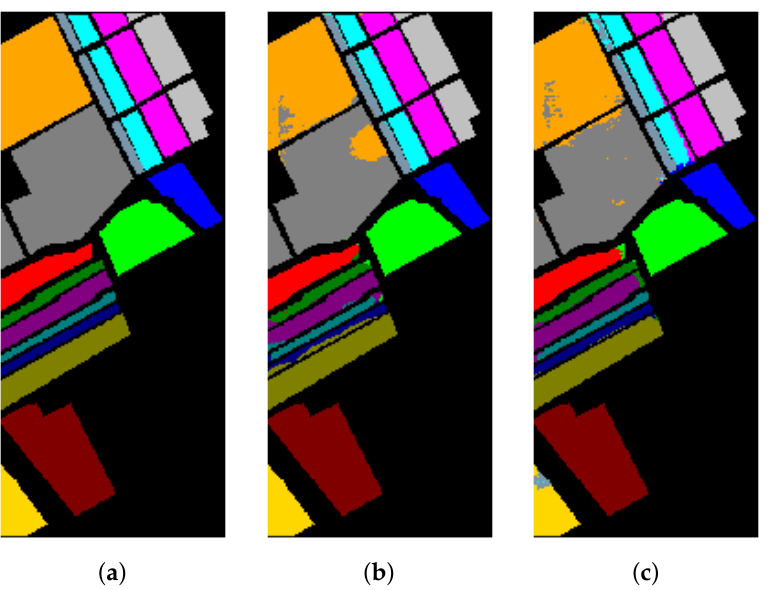
Figure 16. The classification maps of Salinas. ( a ) Ground-truth map. ( b ) Classification results of the Transformer without metric learning. ( c ) Classification results of the Transformer with metric